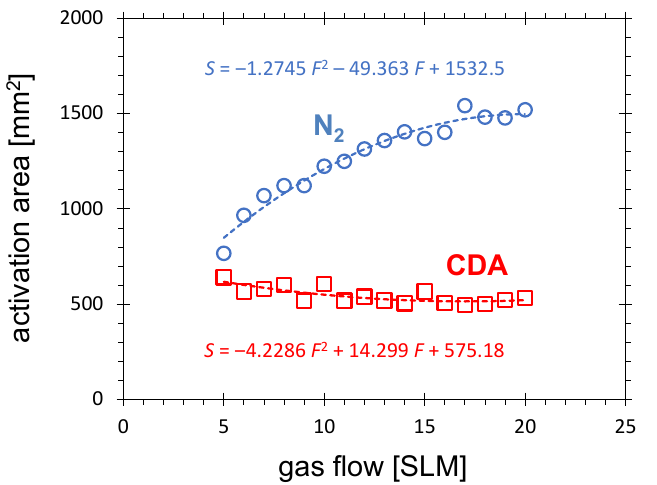
Figure 6. The activation area after N 2 or CDA PDD treatment as a function of gas flow for the distance between the PCPG tip and the HDPE substrate of 5.5 mm, the treatment time of 10 s, and the PCPG input power of 8.0